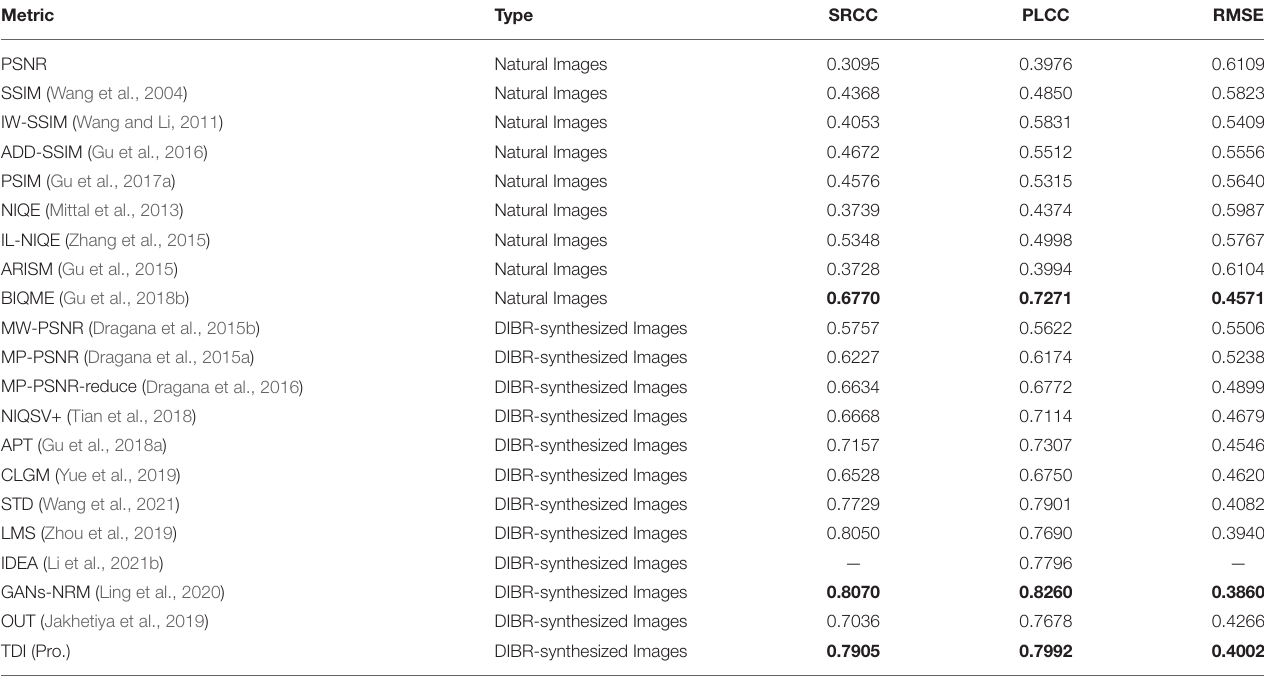
TABLE 1 | Performance comparison of 21 SOTA IQA measures on the IRCCyN/IVC database (Bosc et al., 2011).